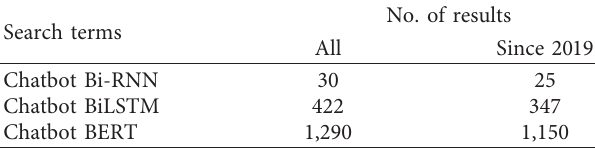
Table 13: Bidirectional related article